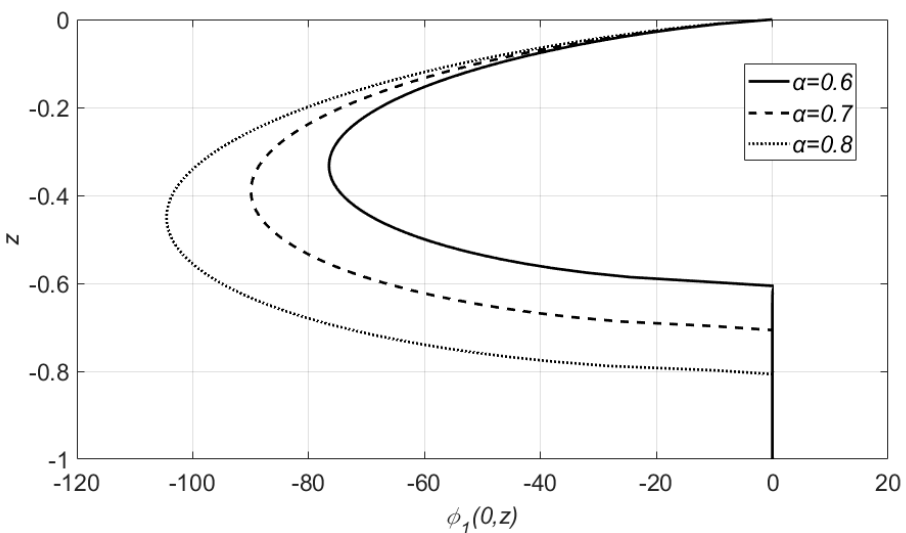
Figure 5. First order velocity potentials on the wall, (cid:2038) (cid:2869) (0, (cid:1878)) , for several air cavity positions and fixed wave impact velocity (cid:1874) = 300 at (cid:1872) = 0.01(cid:1871) .